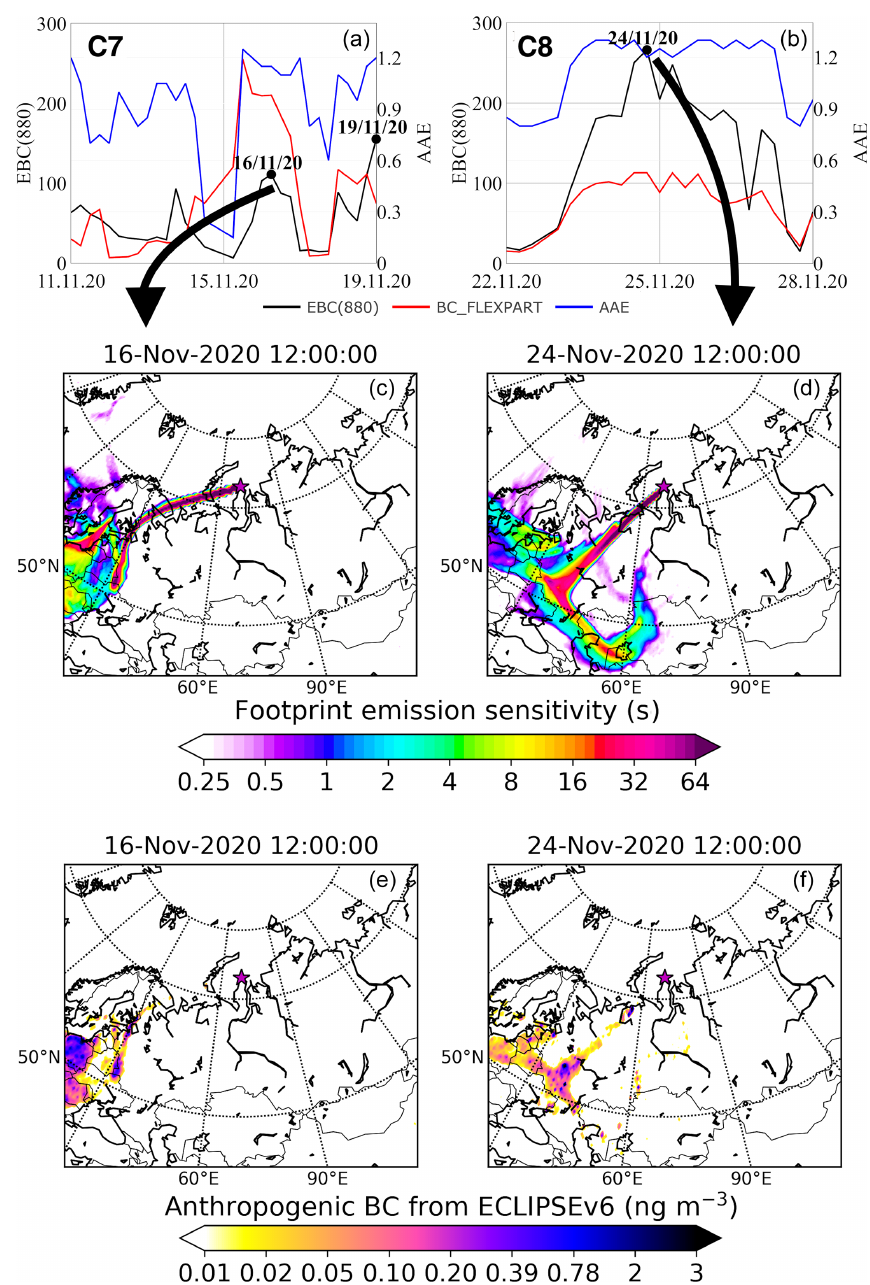
Figure 8. Examples of pollution episodes C7 and C8 observed in the cold period (see Fig. 5a), during which DOM and TRA contributions prevail. Time series of measured EBC, modeled BC and AAE (a, b) , footprint emissions sensitivities (c, d) , and anthropogenic contribution to surface BC (e, f) are